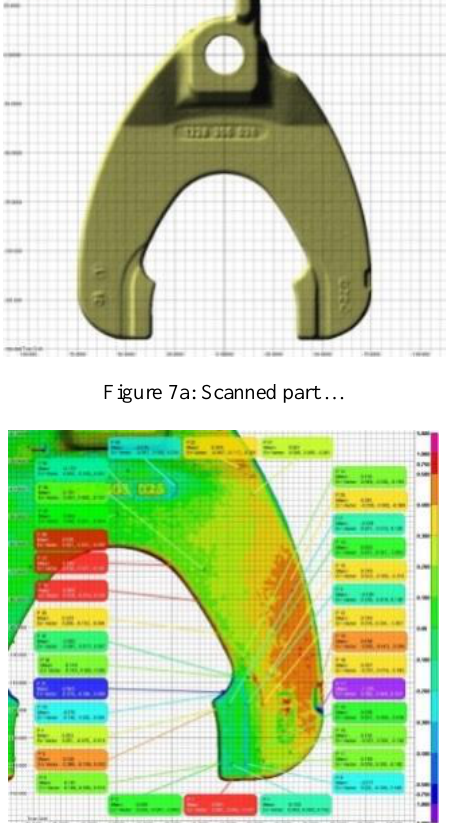
Figure 7b: …. and color deviation map